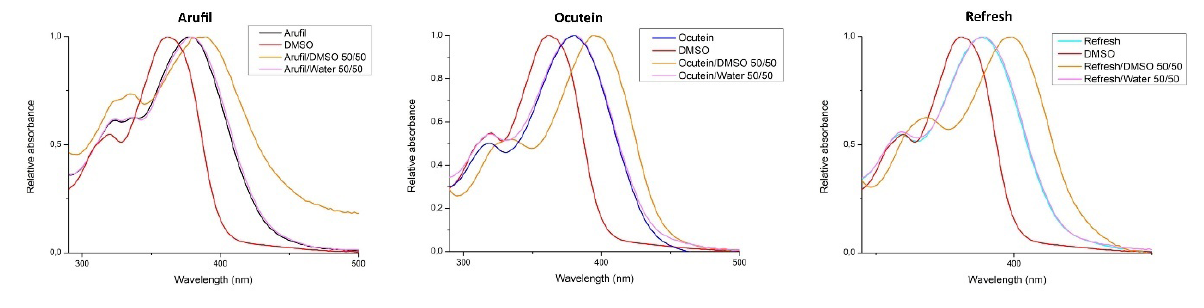
Figure 4: Reversibility of fisetin spectral changes. Fisetin spectra in dimethylsulphoxide (DMSO), Arufil, Ocutein and Refresh before and after addition of DMSO or water in 50/50 ratio to particular eye drops. The spectra of fisetin in Arufil, Ocutein and Refresh were measured after 1:1 dilution of 50 μM fisetin sample with DMSO or deionized water. After mixing up, the spectra of final 25 μM fisetin and 50% DMSO or deionized water content were obtained. Spectral shifts of fisetin absorption peak in Arufil, Ocutein or Refresh to wavelength relative to DMSO or deionized water were not observed suggesting irreversibility of the detected changes.